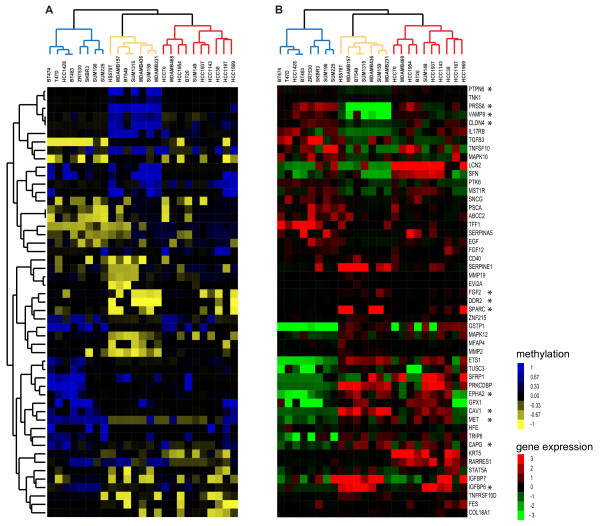
Matched heatmaps of gene expression and methylation profiling. 51 genes whose epigenetic-regulated expression varied between the three expression clusters. (A) Methylation heatmap (left) illustrates unmethylated probes in yellow, methylated in blue and partially methylated in black. (B) Expression heatmap displays the mean centred expression level for the corresponding gene. BC cell lines are ordered based on the gene expression clustering, and groups are illustrated as blue, orange and red dendrogram branches for “Cluster 1, 2 and 3” BC cell lines, respectively. Genes of the Claudin-low signature are indicated with asterisks.